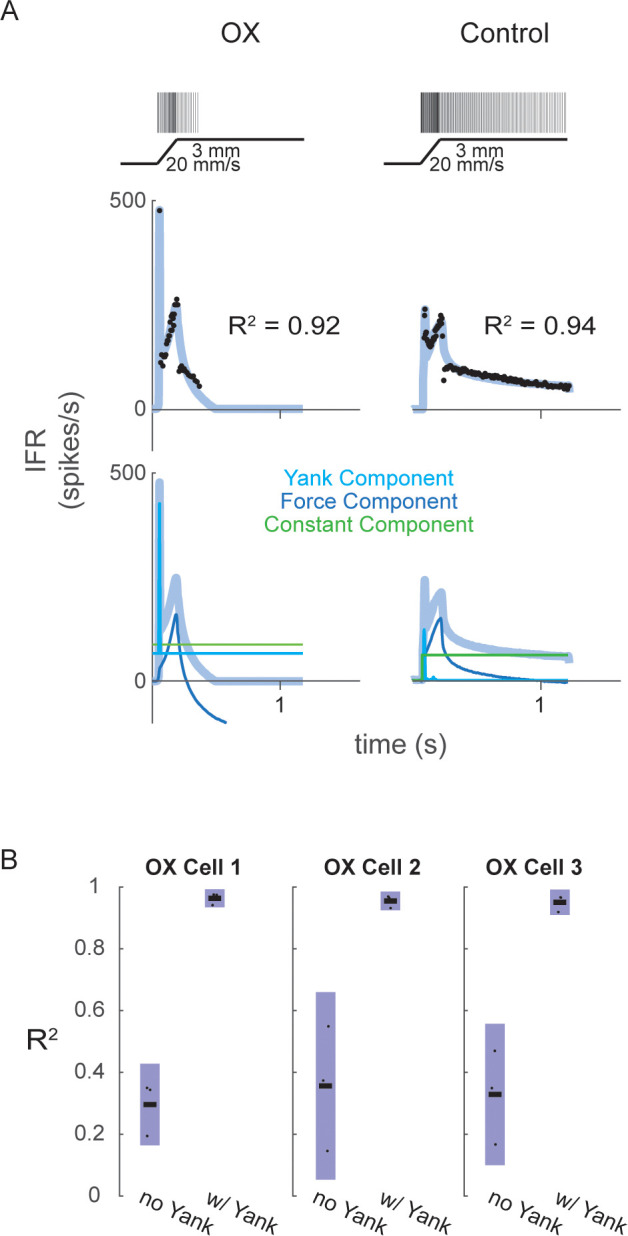
Fits of muscle spindle firing rates before and after oxaliplatin-induced neuropathy using estimated muscle fiber force and yank.(A) Example Ia afferent responses to stretch and force-based model fits. Left column shows a typical Ia afferent response to a ramp-hold stretch applied to the triceps surae of a rat treated with oxaliplatin chemotherapy (Bullinger et al., 2011). Right column shows typical response of Ia afferent in response to same ramp-hold stretch. Raster plots indicate times at which action potentials are recorded and are shown above imposed stretches. Below are the IFR and corresponding model fits shown above the same model fits with their respective components. (B) Variance of muscle spindle Ia afferent responses accounted for by force related model with (right bar in each plot) and without (left bar in each plot) yank for three Ia afferents from three oxaliplatin-treated rats. Black horizontal bars represent the means, blue bars represent the standard deviations, and black dots represent the data points from each trial (three trials per afferent).